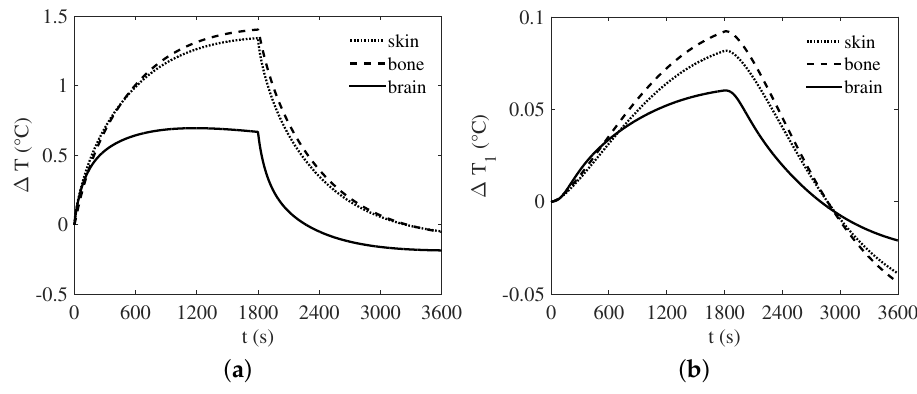
Figure 5. ( a ) Time-dependent temperature rise in the skin, bone, and brain layers; ( b ) comparison between non-thermoregulated and thermoregulated